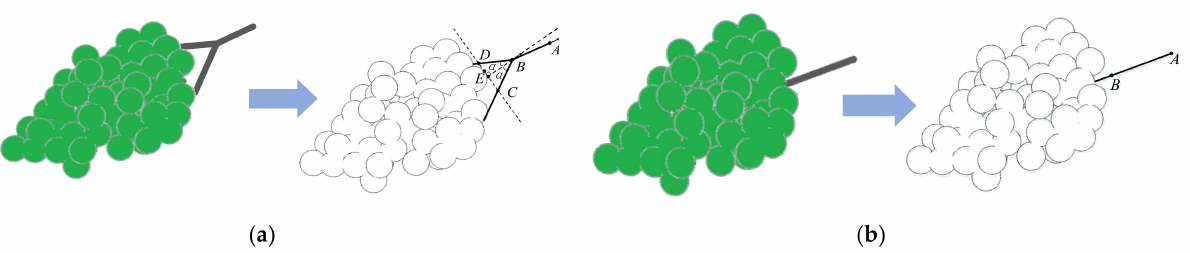
Figure 9. Stalks. ( a ) Stalk with node; ( b ) stalk without